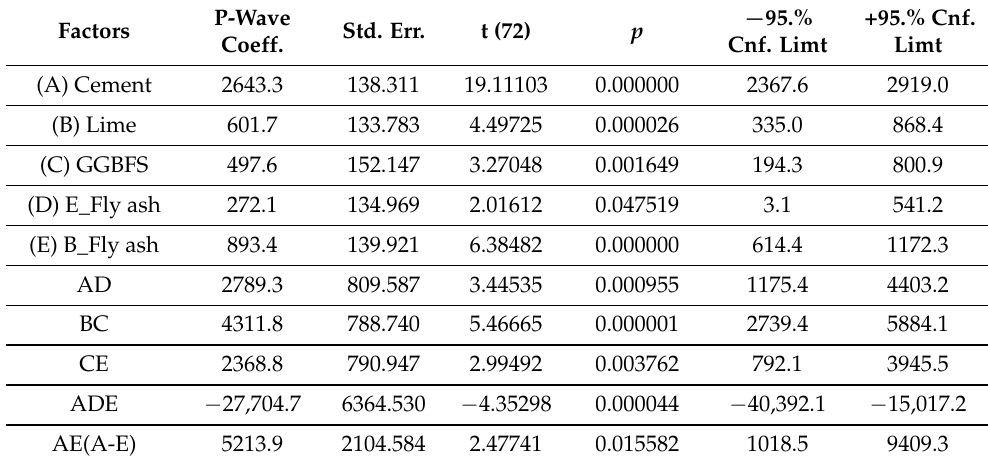
Table 2. Remaining significant effects on day 7th after the backward elimination.